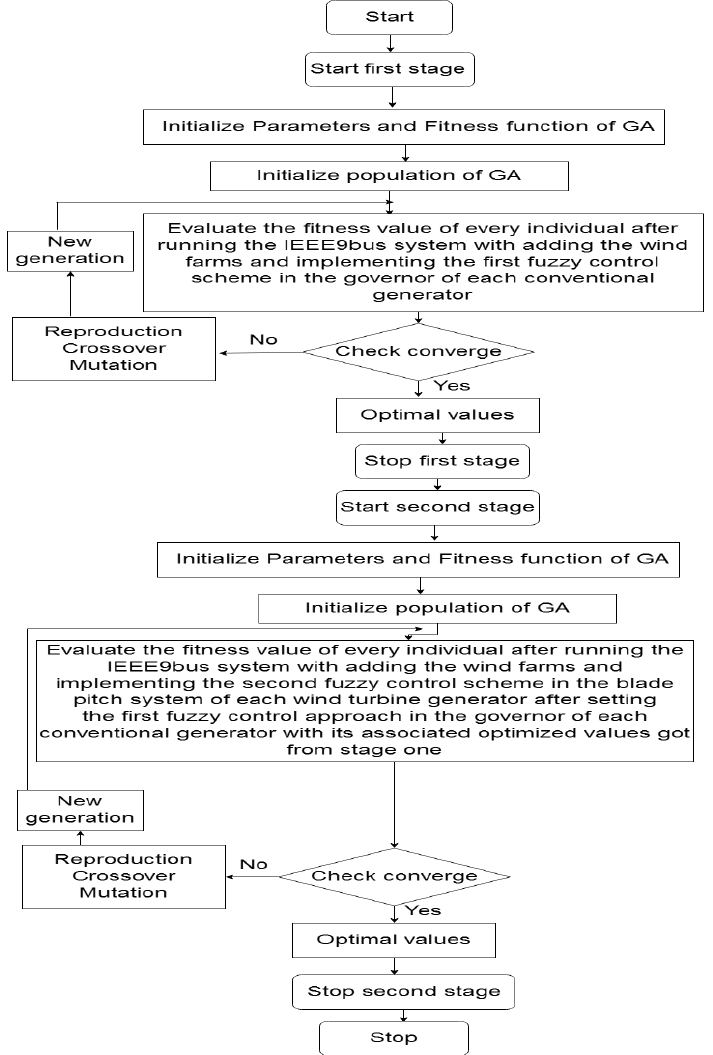
Figure 7. Flowchart of the design process of two GA–fuzzy-based control schemes. GA: genetic